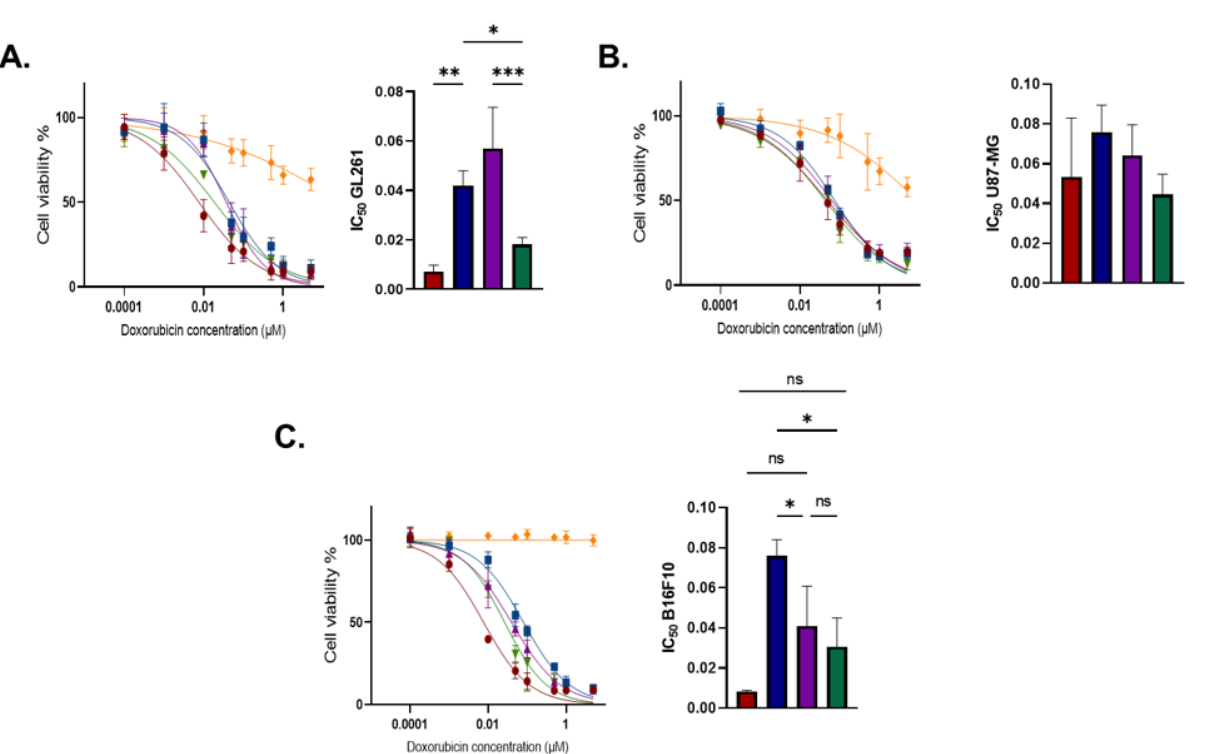
Figure 1. Effect of DOX and HA-DOX conjugates on cell viability. ( A ) GL261, ( B ) U87-MG, and ( C ) B16F10 were incubated with free DOX, HA, HA-NH-DOX, HA-AdpHz-DOX, and HA-Hz-DOX conjugates, in a concentration range of 0.0001–5 µ M in DOX equivalent. After 72 h of incubation, the cell viability assay was performed via crystal violet staining, and data were obtained by calculating the crystal violet mean fluorescence intensity. Mean, error bar = SD, N = 3, statistical analysis obtained by one-way ANOVA multiple comparison (ns = not significant, * p < 0.05, ** p < 0.01, *** p < 0.001). Free DOX: red; HA: yellow; HA-NH-DOX: blue, HA-AdpHz-DOX: violet; HA-Hz-DOX: green.